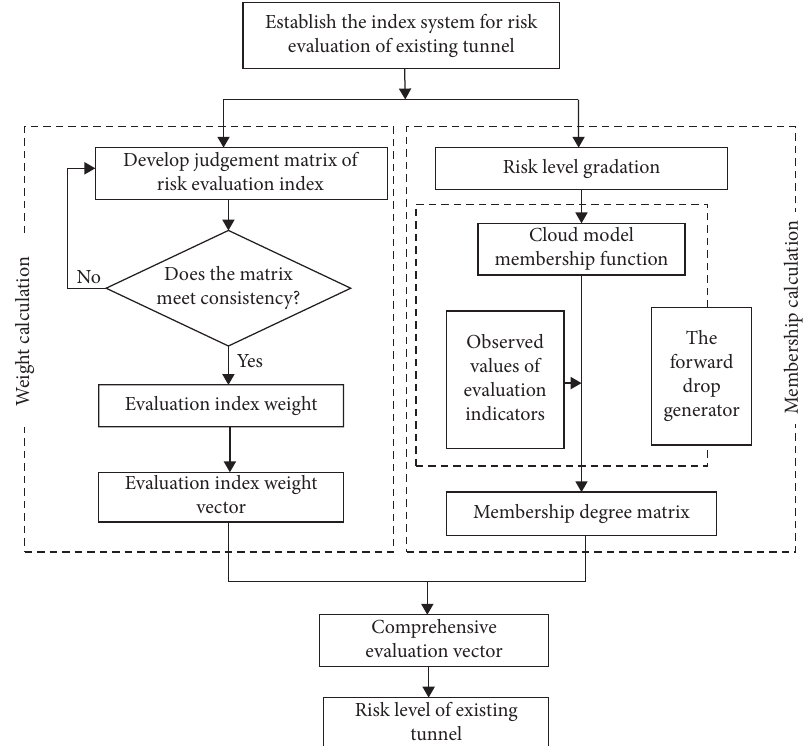
Figure 4: Flowchart of existing tunnel risk level